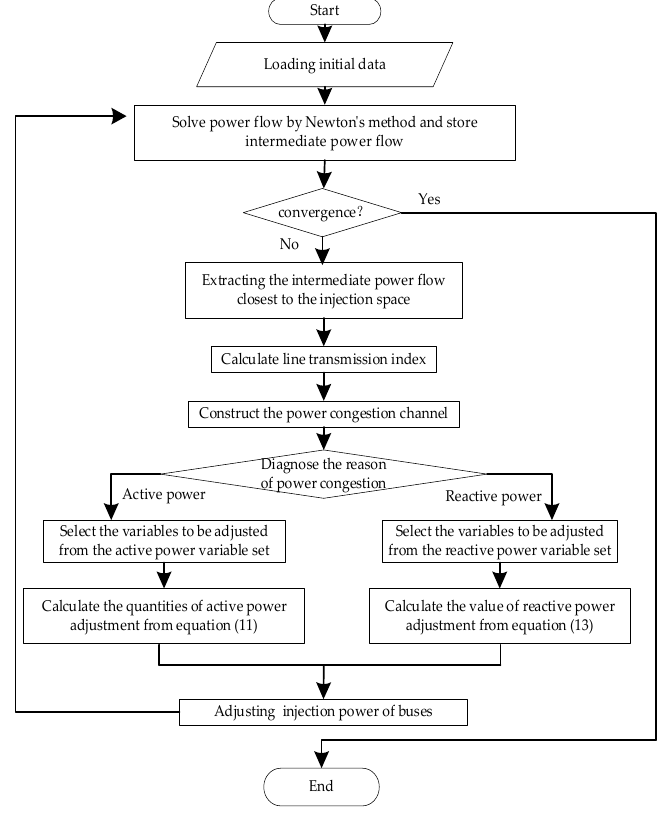
Figure 4. Flow chart of power flow adjustment.